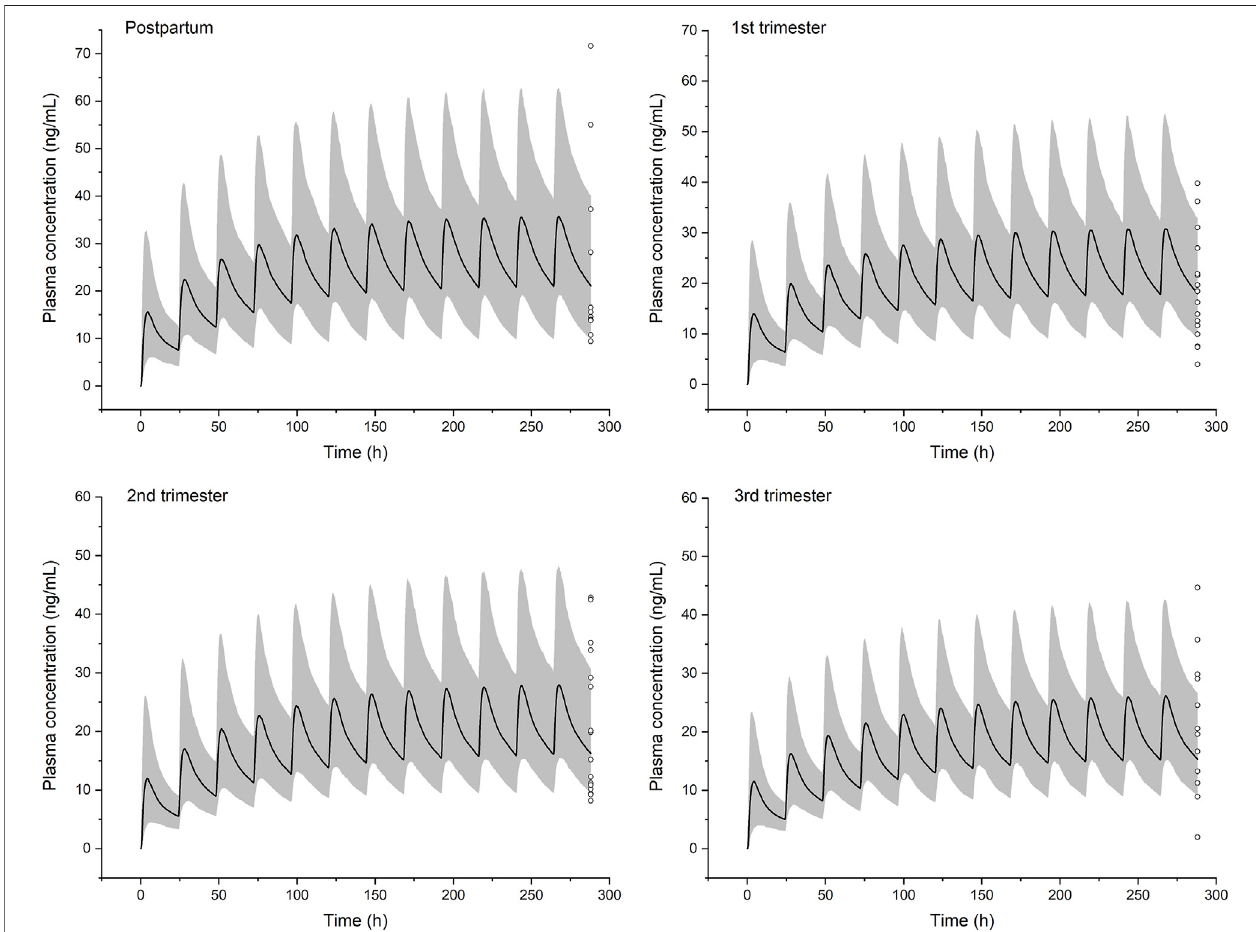
FIGURE 6 | Simulated pharmacokinetic pro fi les of olanzapine in non-pregnant women and women in the three stages of pregnancy receiving 10 mg daily dose. Median plasma concentrations are shown as dark lines, and shaded areas indicate 5th to 95th prediction range. Circles are individual olanzapine concentration data in